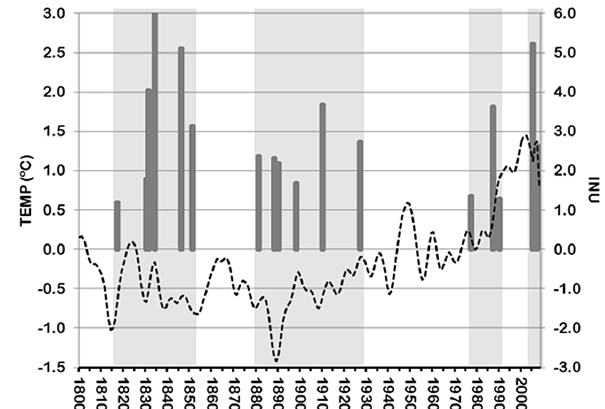
Figure 10. Temporal evolution of the standardized anomalies of INU (full line; INU >1.5SD) and the annual average temperature for Switzerland (dashed line) for the period 1800–2009. Both series are plotted as normalized values and temperature data are smoothed with an 11-year low-pass Gaussian